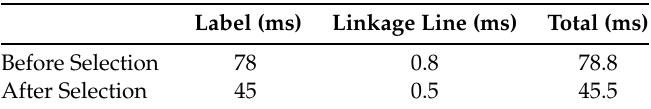
Table 11. Comparison of processing speed of feature calculation before and after feature selection (assuming that the physical area of a region of interest (ROI) and the length of the linkage line are 10 cm × 2 cm and 10 cm, respectively).